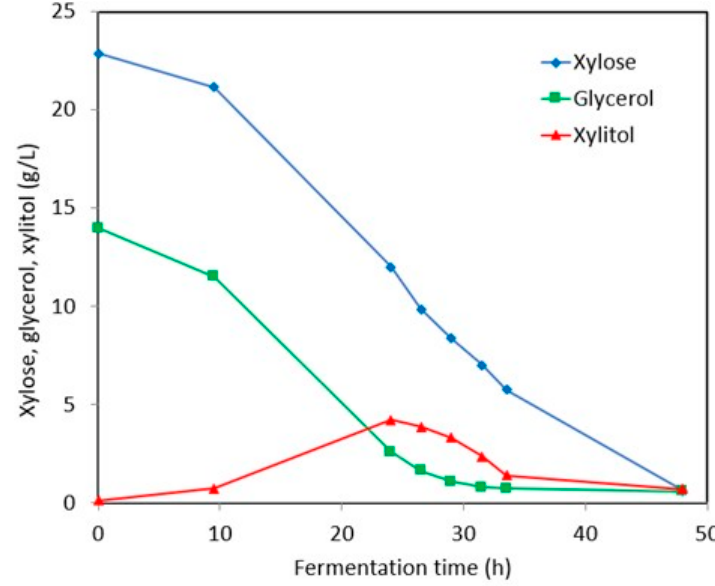
Figure 4. Concentration profiles of xylose ( ♦ ) glycerol ( ■ ) consumption, and xylitol ( ▲ ) generation by C. mogii cultivated in synthetic media containing xylose and glycerol at initial concentrations equal to those in detoxified and concentrated stillage media.